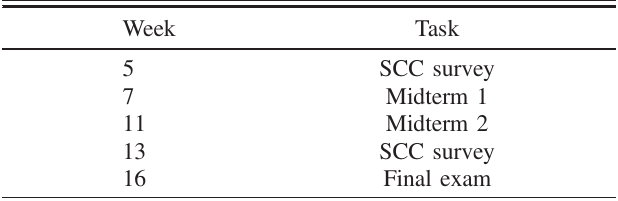
TABLE I. Schedule for social comparison survey and